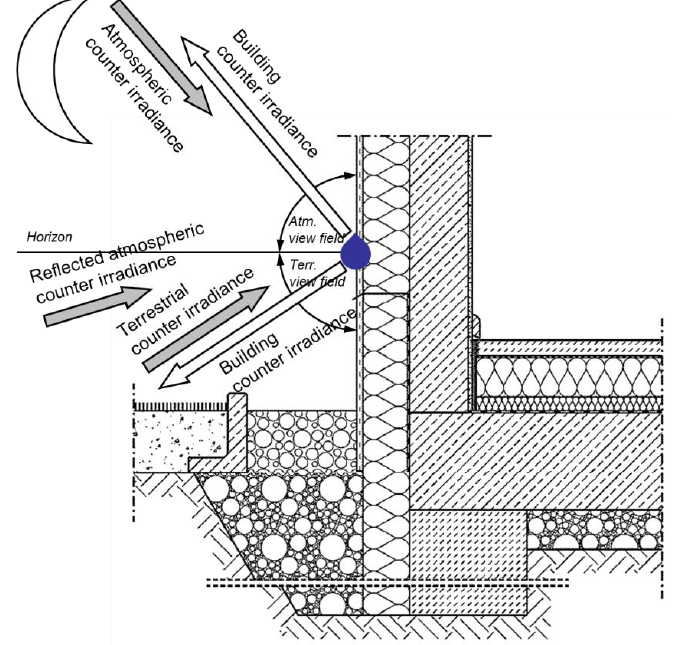
Figure 6. Long-wave radiation conditions on a vertical exterior